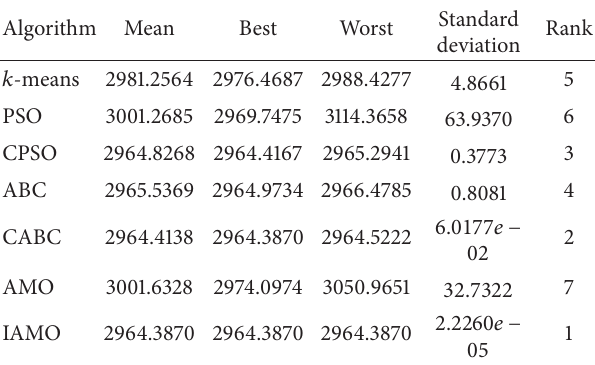
Figure 5: The convergence curve of the Art1 data.